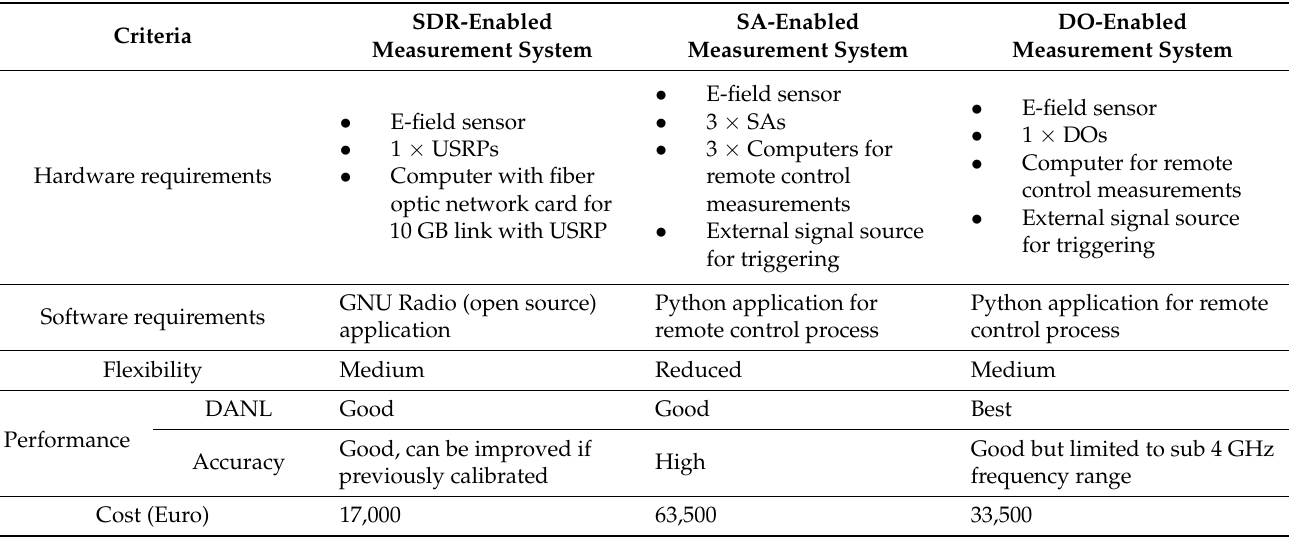
Table 2. Comparative analysis of the measurement systems.